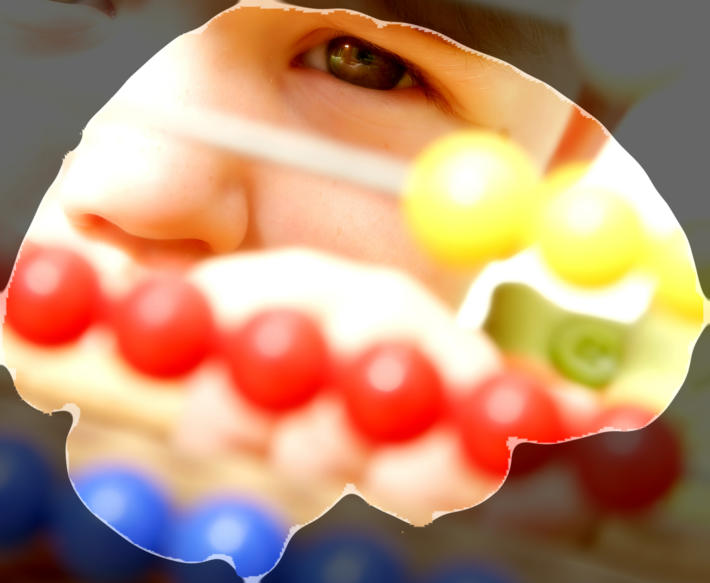
The brain circuits for comprehending math are already in place early in development.